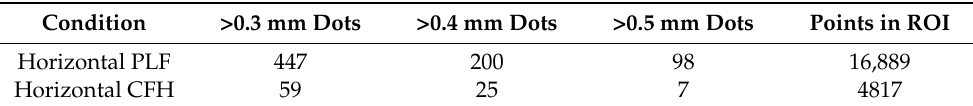
Table 2. Horizontal comparison data table of castings.